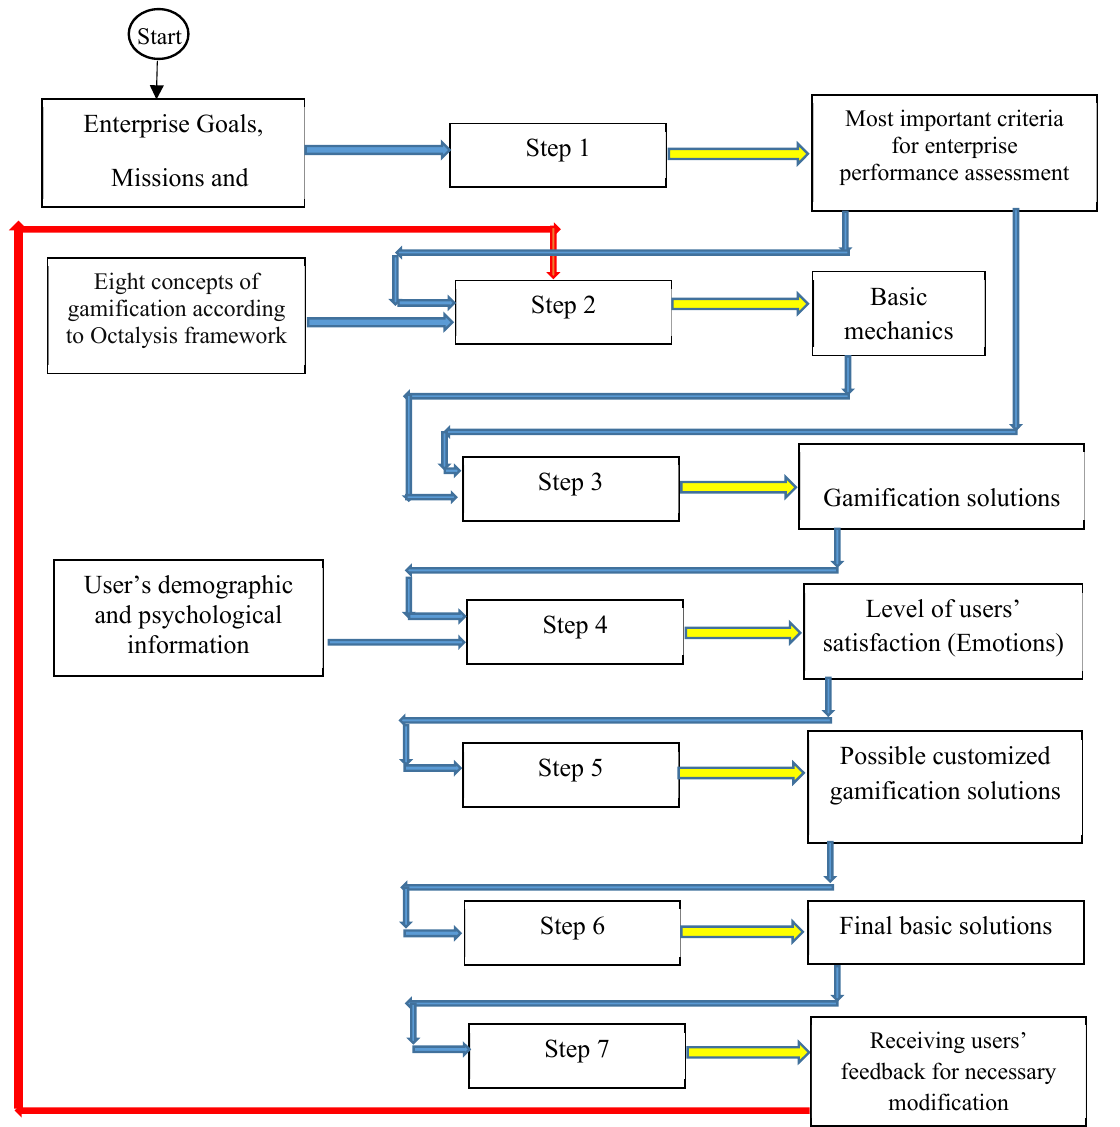
Fig. 5. Diagram of methodology steps, Steps Inputs: Blue, Steps Outputs: Yellow, Feedback: